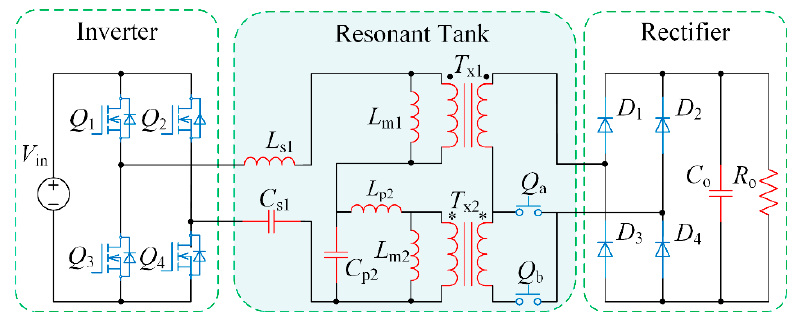
Figure 1. Topology of the proposed converter.